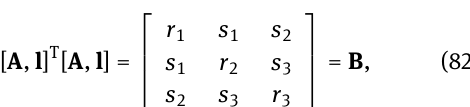
Table 10: Direct LS solution for plane fit in 3D